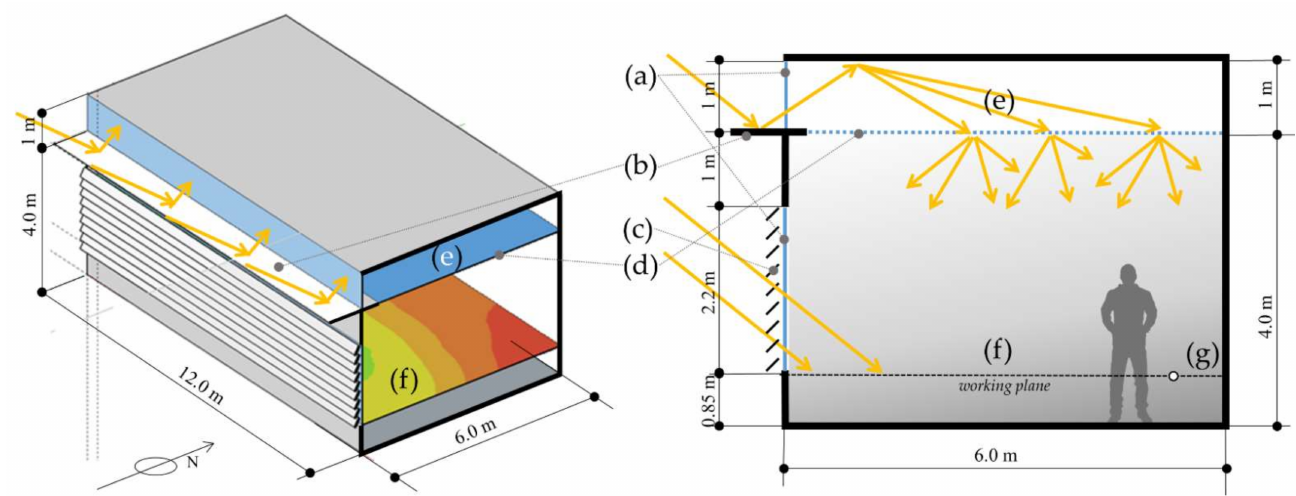
Figure 1. The geometry of the test room: on the right, an axonometric section showing the plenum, and on the left, the schematic section showing the location of transparent (marked in pale blue) and translucent surfaces in the test room (marked in blue, dotted line). Description: ( a ) transparent glass: clerestory window and regular window in the façade; ( b ) light shelf; ( c ) horizontal louvres; ( d ) translucent ceiling; ( e ) daylight distribution plenum; ( f ) evaluated working plane ( g ) illuminance sensor A—used in Variant